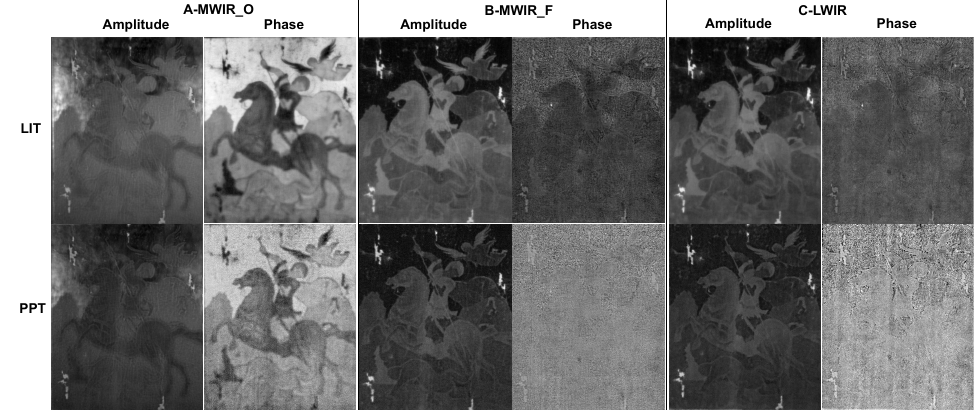
Figure A3. All measurement results for the St George painting, grouped by camera and